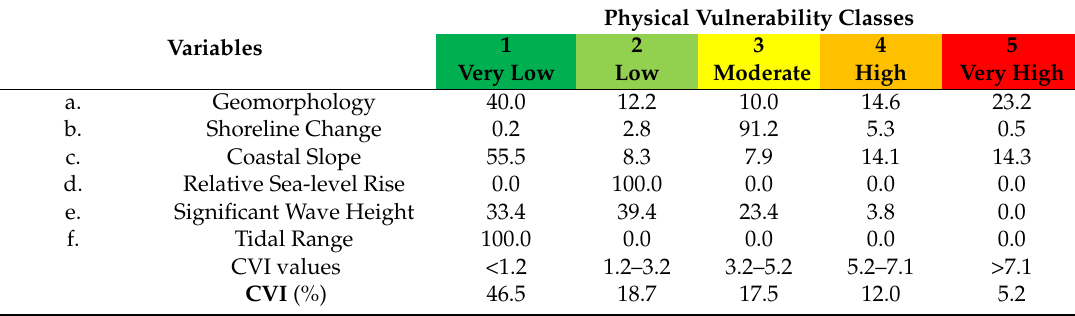
Table 2. The coastline length (as percentage % of the total shoreline length) in each vulnerability category (1–5) for the physical variables (a–f) of the